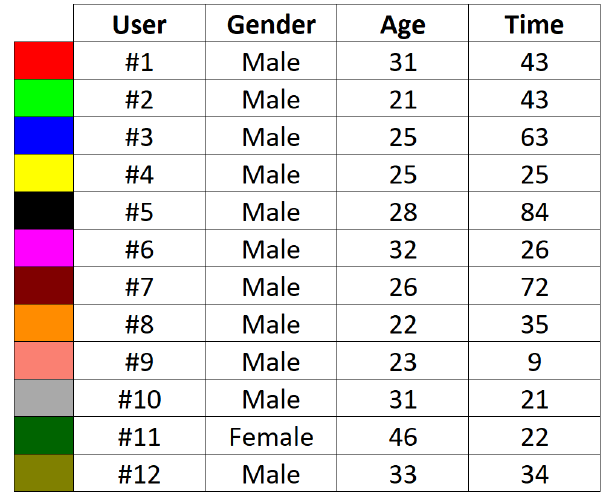
Figure 17. Top view of mean user positions generated by the proposed viewer tool. As reference, the TV is located in the bottom part of the image. To better understand the setup please refer to Figure